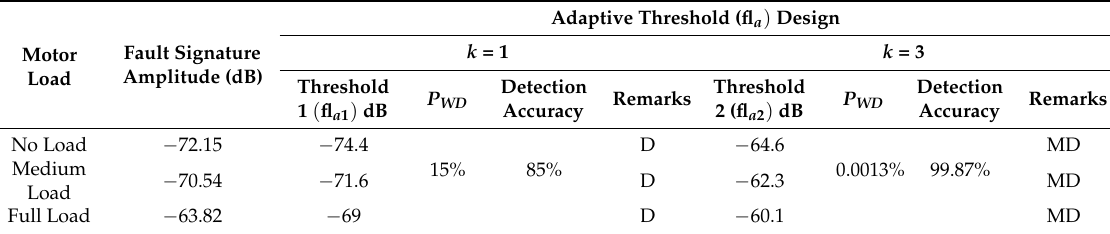
Table 5. Performance evaluation of adaptive threshold